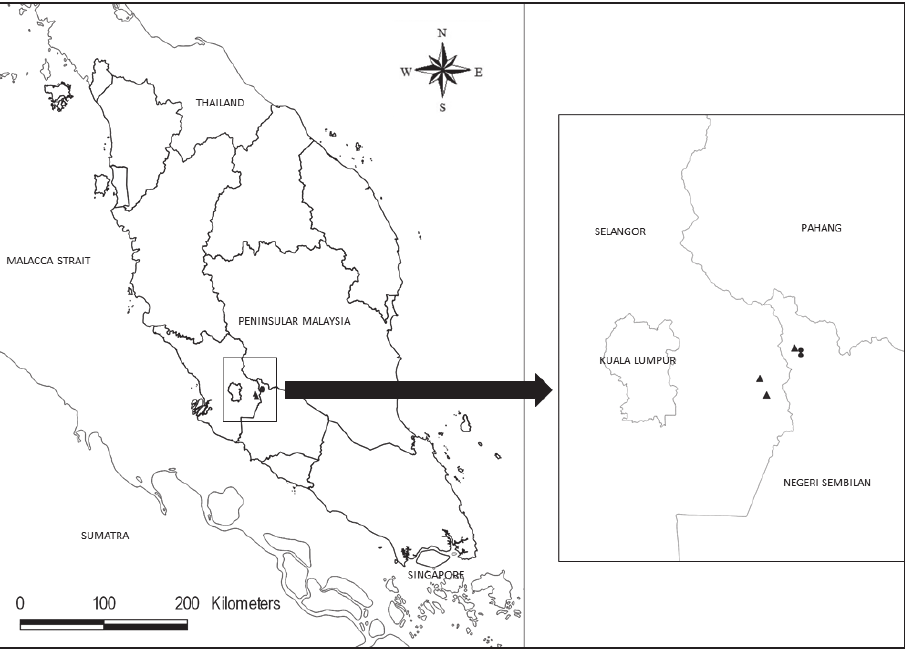
Map 1. Distribution of Codonoboea kenaboiensis (circle) and Codonoboea ruthiae (triangle) in Peninsular